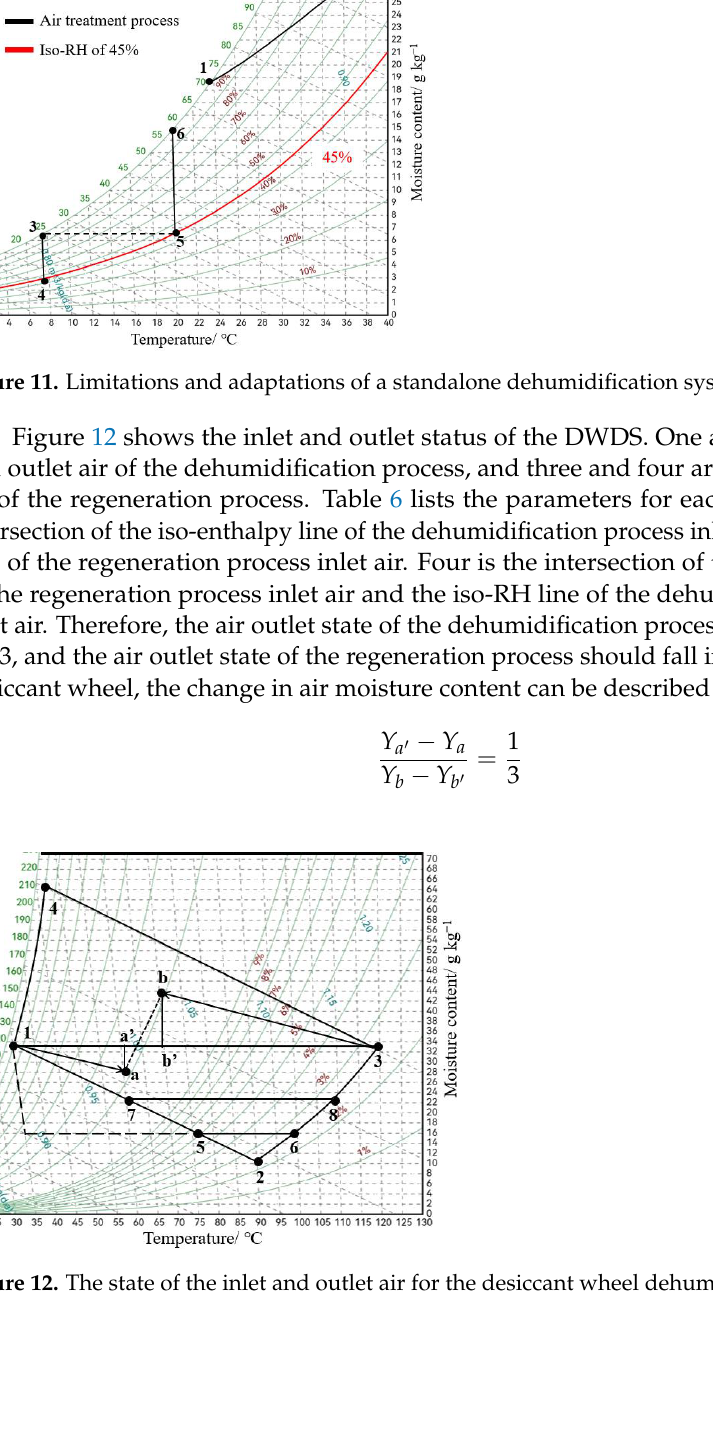
Table 6. Inlet and outlet status parameters.